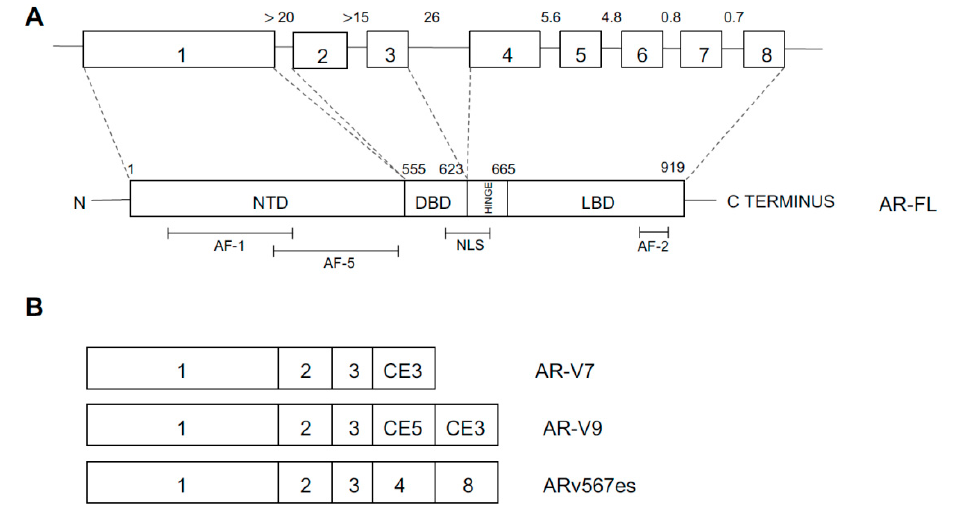
Figure 3. Gene and protein organization of AR and AR variants. ( A ) Human AR is encoded by a single gene located at Xq 11–12 and is normally organized into 8 exons, encoding a protein of 919 amino acids. The full-length AR protein (AR-FL) is divided into structural and functional domains: (i) a large amino terminal transactivation domain (NTD) containing activation function-1 (AF-1) and activation function-5 (AF-%); (ii) a DNA-binding domain (DBD); and (iii) a small hinge region, containing a nuclear localization signal (NLS), and a ligand-binding domain (LBD), containing activation function-2 (AF-2). It is important to note that cryptic exons (CE) are located either between exon2 and 3 (CE 2b/CE4) or between exon 3 and 4 (CE1, CE2, CE3, CE5, and 3 ′ ): alternative splicing of CEs can give rise to carboxy-terminally truncated AR isoforms. ( B ) Structure of three clinically relevant AR-Vs: AR-V7, AR-V9 and Arv567es.